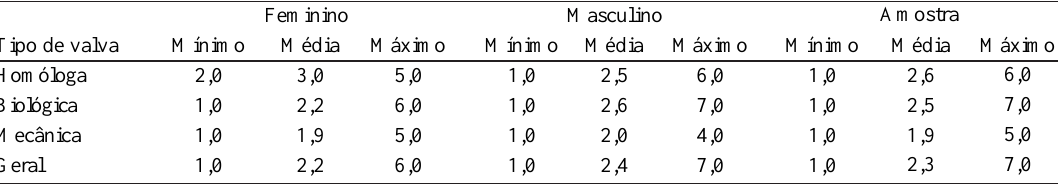
Tabela 1. Medidas descritivas dos tempos de internação na Unidade de Terapia Intensiva (em dias) por sexo e tipo de